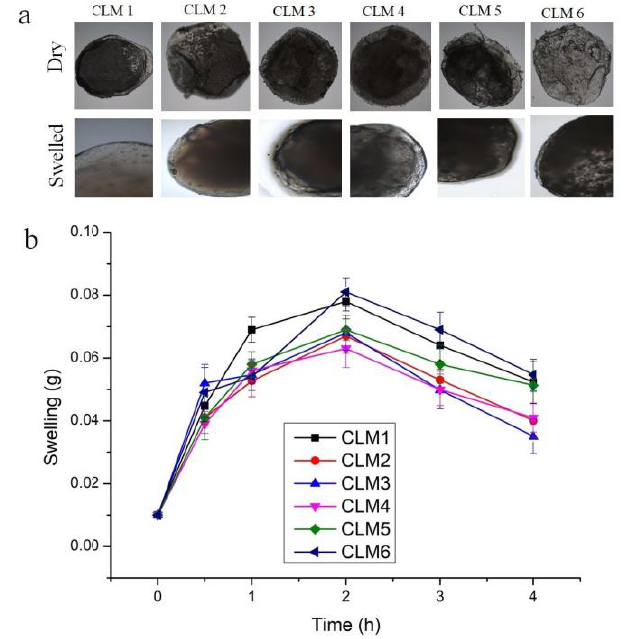
Figure 3. ( a ) Optical images of all formulations in dry and in swollen form after four hours in pH 1.2. ( b ) Swelling of all formulations at different time intervals. Error bars represent standard deviation (n = 3).